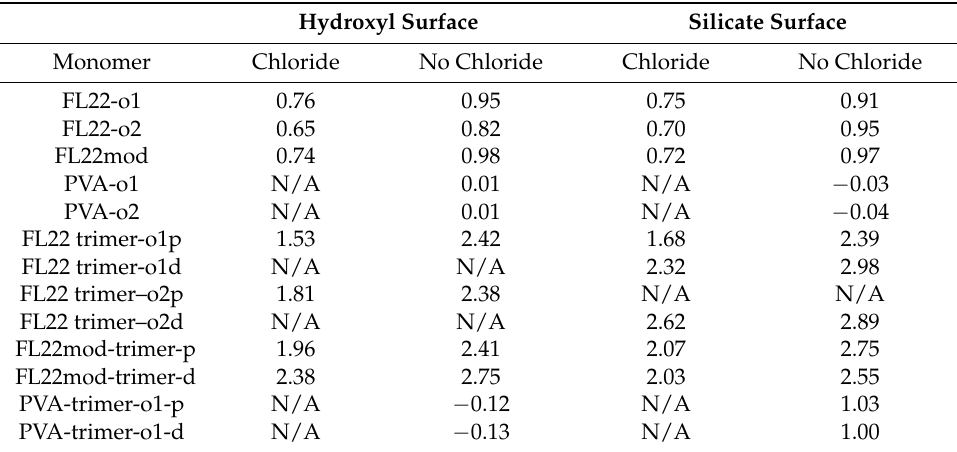
Table 6. Mulliken charges (e) of the monomers post relaxation in orientations 1 (o1) and 2 (o2) and the trimer configurations lying either parallel (p) or diagonal (d) to the surface.